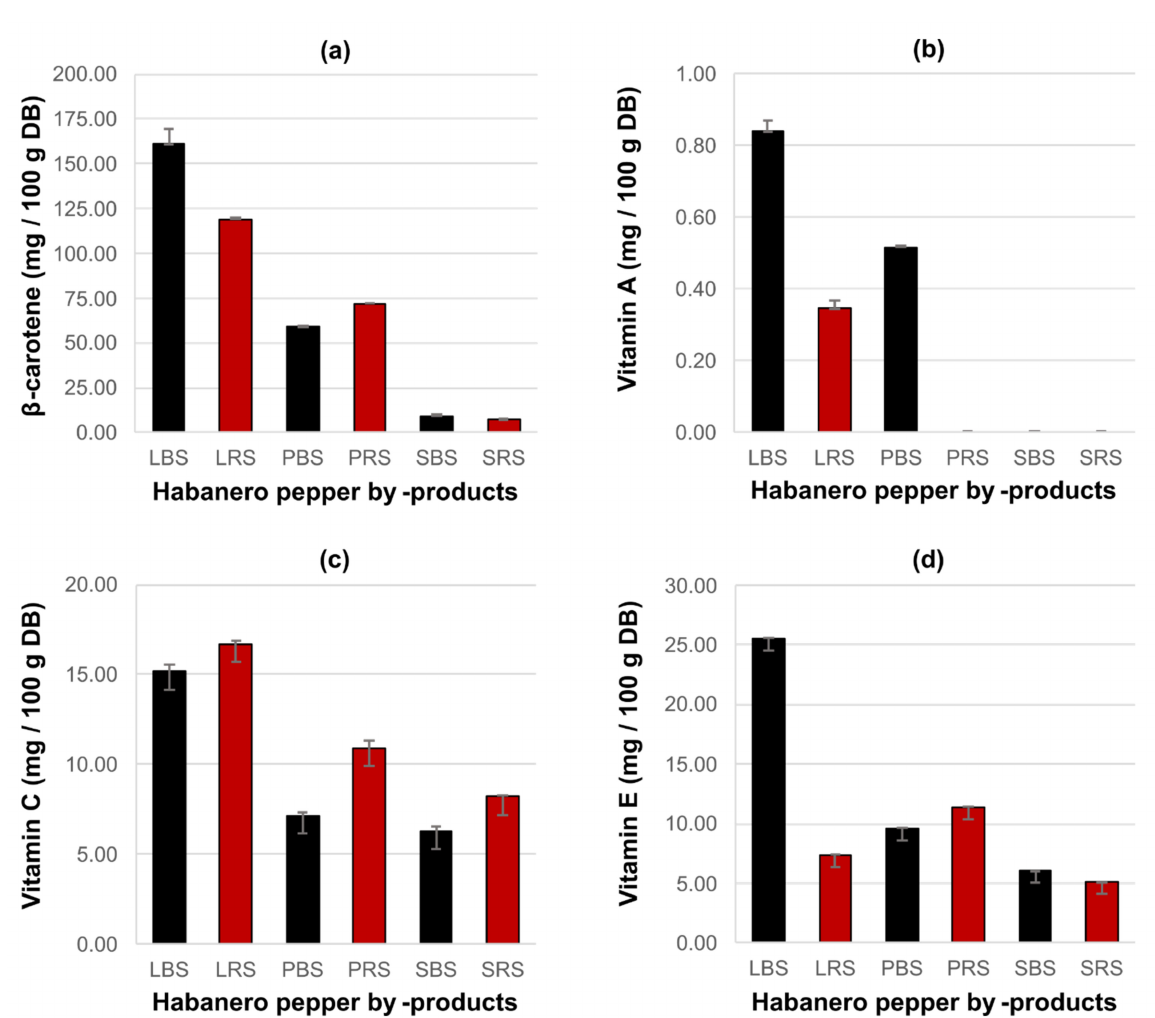
Figure 1. The effect of the factors type of soil and by-product on different response variables: ( a ) β -carotene content, ( b ) Vitamin A content, ( c ) Vitamin C content, and ( d ) Vitamin E content. The error bars on the figure represent the standard deviation (n = 2). DB: Dry basis; LBS: Leaves of plants grown in black soil; LRS: Leaves of plants grown in red soil; PBS: Peduncles of plants grown in black soil; PRS: Peduncles of plants grown in red soil; SBS: Stems of plants grown in black soil; SRS: Stems of plants grown in red